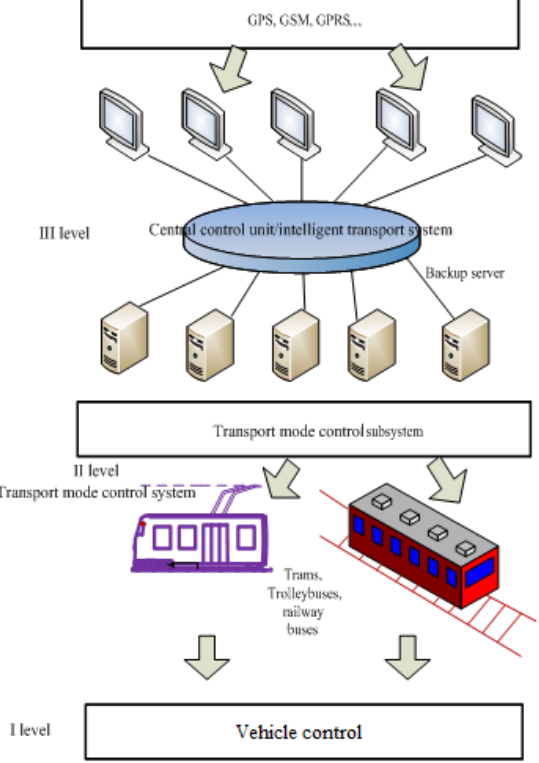
Fig. 3. Structure of 3-level intelligence transport control